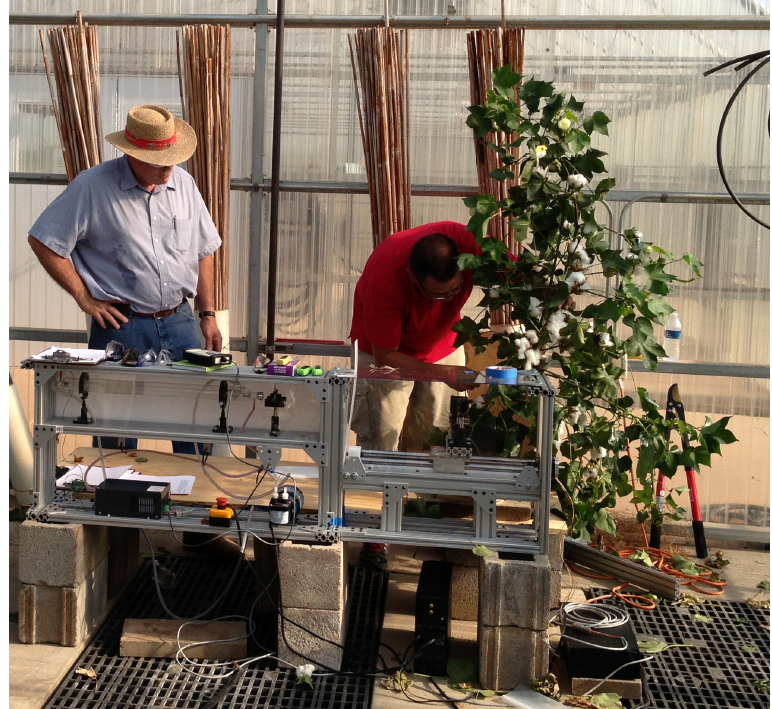
Figure 7. Girdling with CNC CO 2 laser treatment system on greenhouse ‐ grown cotton plants.